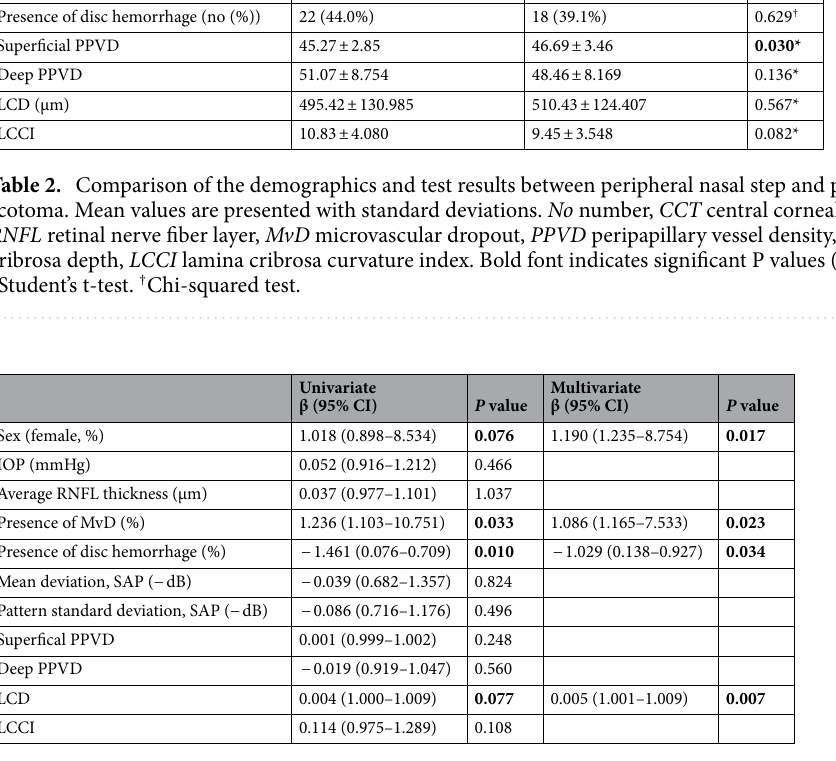
Table 3. Factors associated with the SAP–FDT difference using logistic regression analysis. CI confidence interval, IOP intraocular pressure, RNFL retinal nerve fiber layer, MvD microvascular dropout, SAP standard automated perimetry, PPVD peripapillary vessel density, LCD lamina cribrosa depth, LCCI lamina cribrosa curvature index. Variables with P < 0.10 were included in the multivariate analysis. Factors with statistical significance are shown in